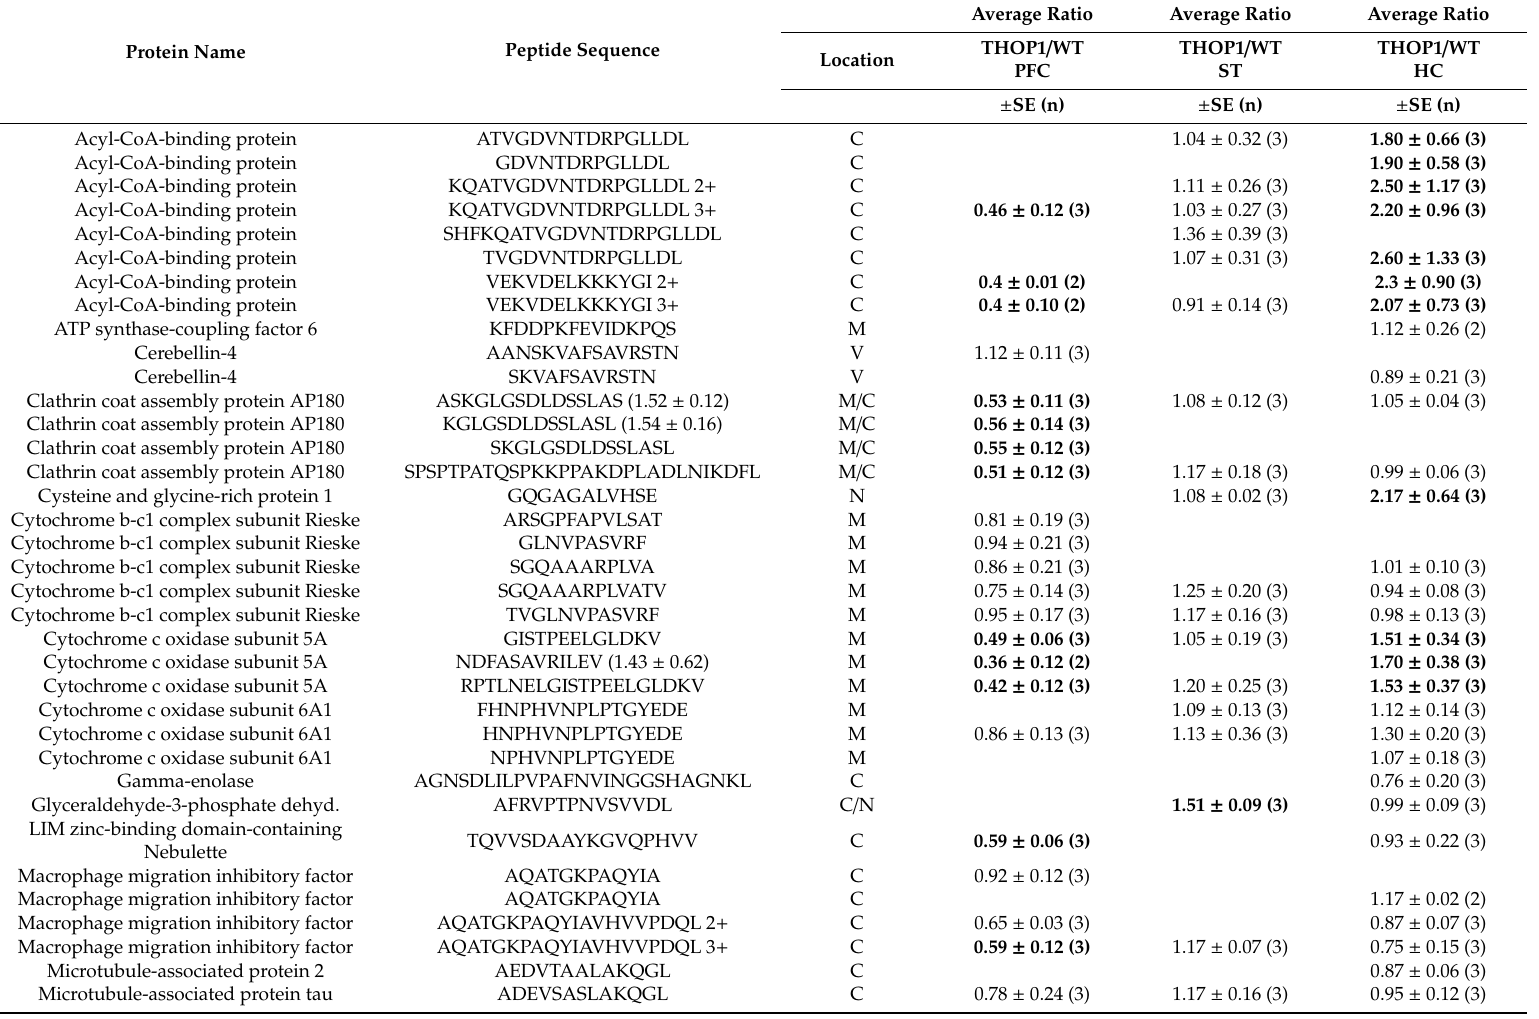
Table 1. Relative quantification of peptides from prefrontal cortex (PFC), striatum (ST), or hippocampus